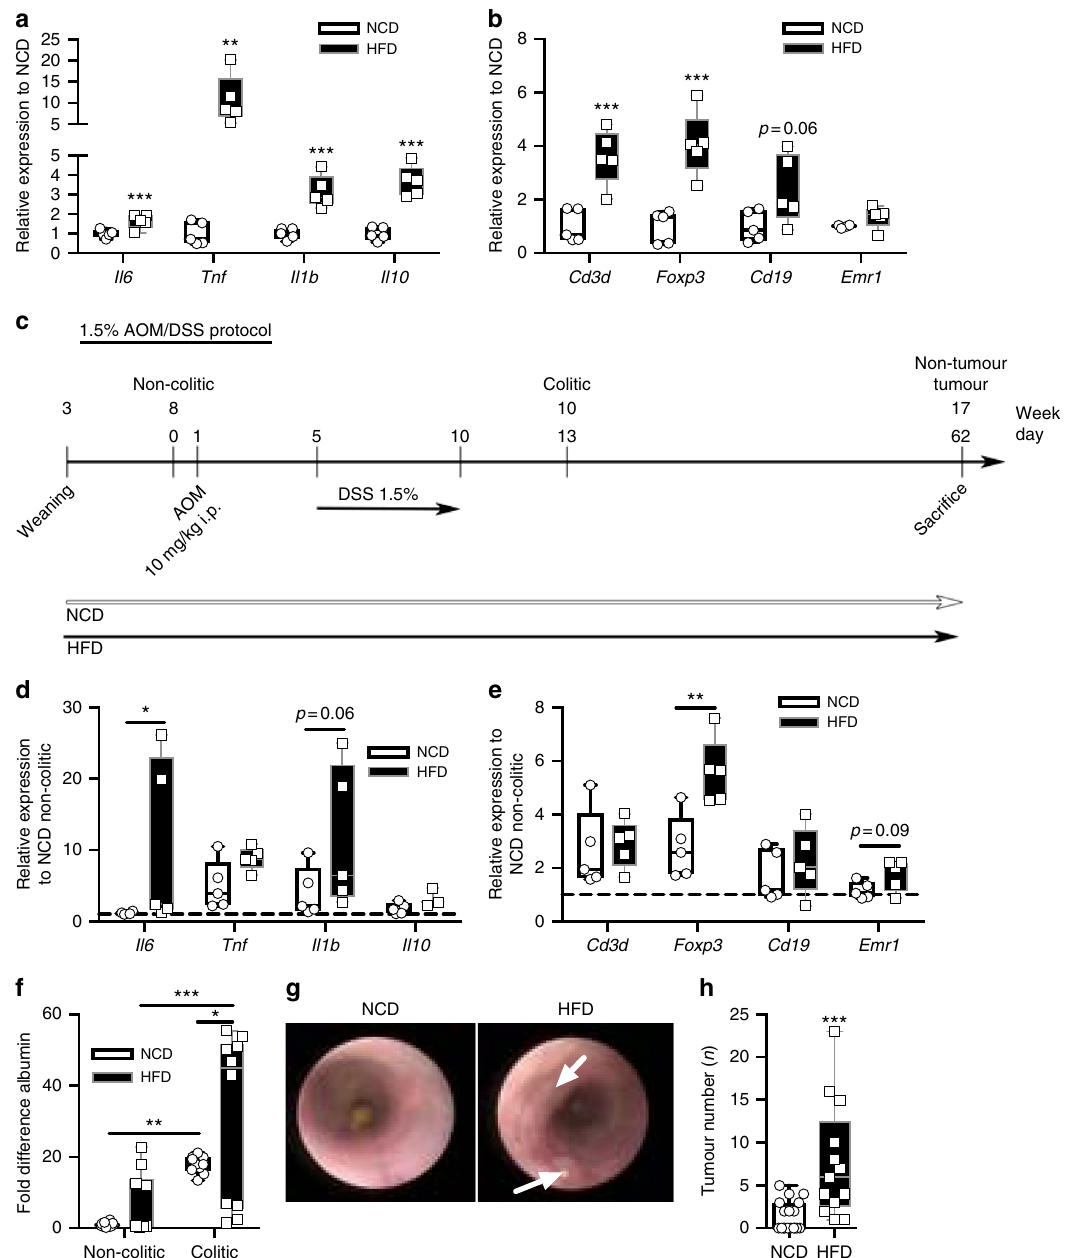
Fig. 1 Obesity enhances colonic in fl ammation and CAC tumour burden in C57BL/6 mice. a , b qPCR analysis of indicated gene expression in distal